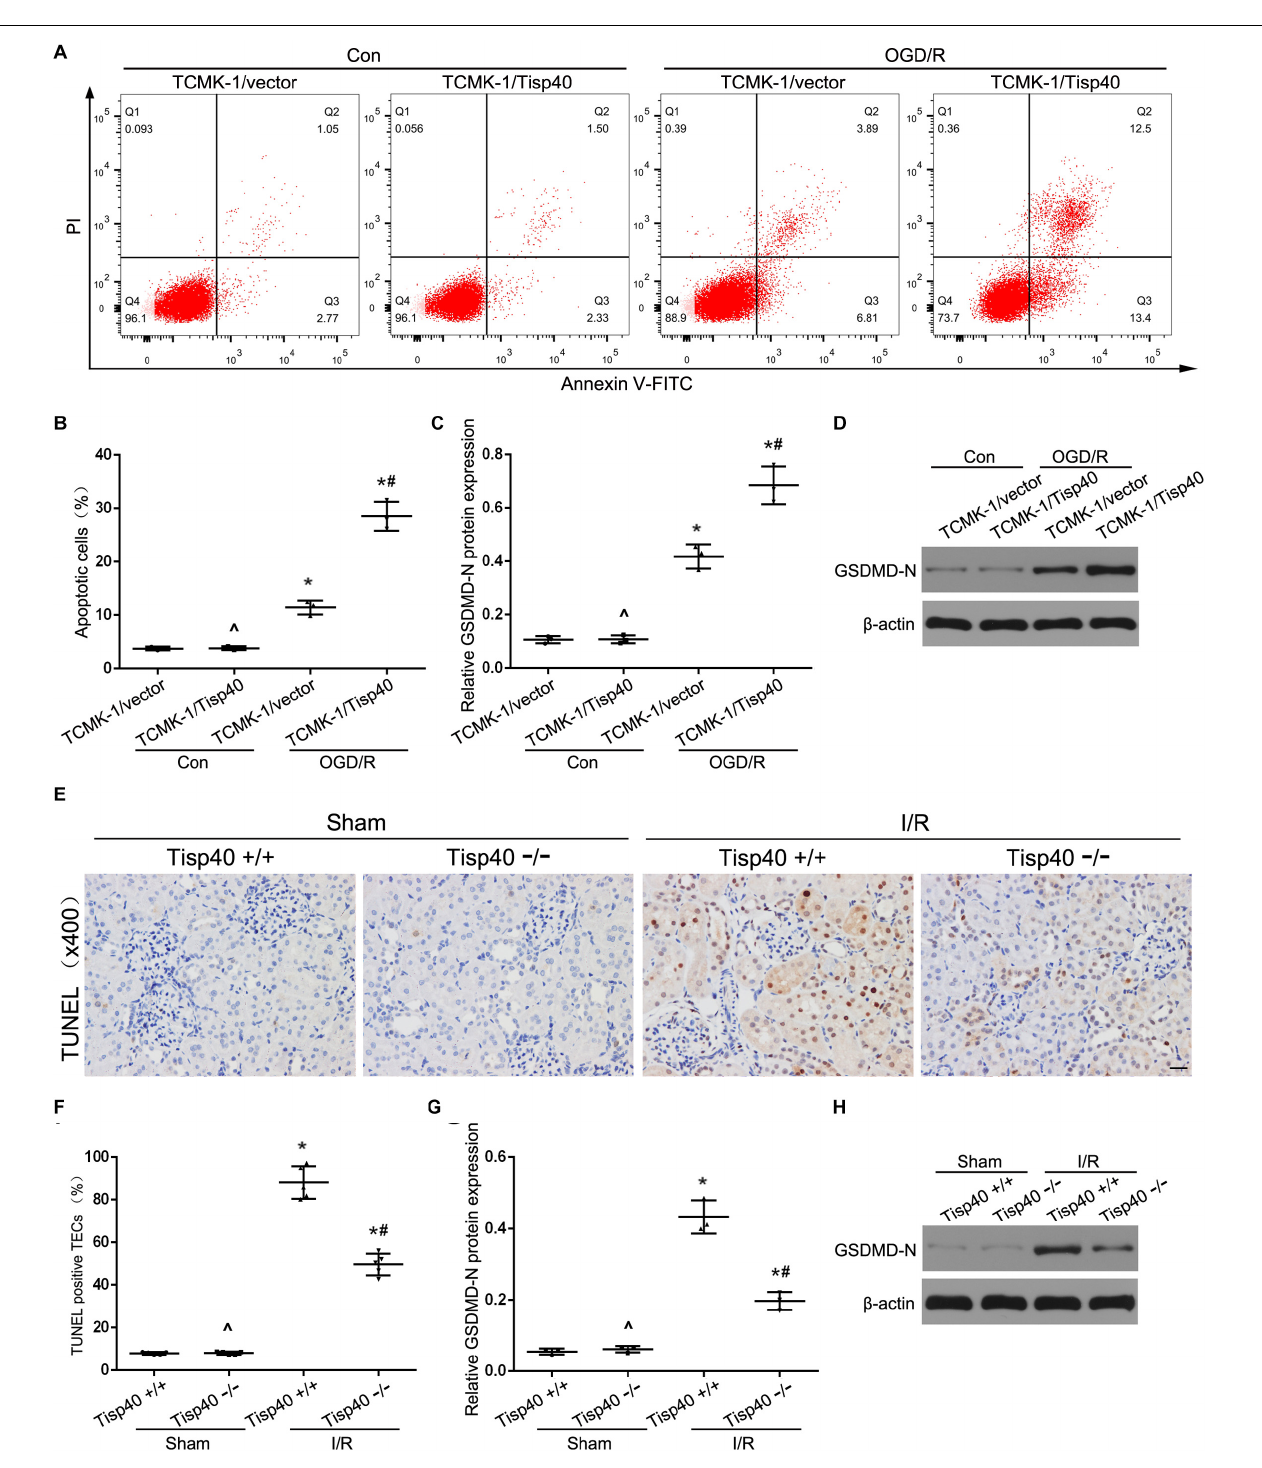
FIGURE 6 | Tisp40 was an essential regulator of GSDMD-mediated TECs pyroptosis. (A) Flow cytometry assays were performed to show the cell pyroptosis. (B) Statistical analysis was used to show pyroptosis cells. (C,D) The expression of GSDMD-N in TCMK-1 cells were analyzed by Western blot. (E) Representative photomicrographs of tubular cell injury in mouse kidney tissue sections with TUNEL staining, 400 × , scale bar = 20 µ m. (F) Statistical analysis showed the percentage of TUNEL positive TECs in the kidney tissues exposed to sham or I/R. (G,H) The expression of GSDMD-N in kidneys were analyzed by Western blot. Data are expressed as the mean ± SD. n = 5 per group in vitro and n = 6 per group in vivo . ˆP > 0.05 vs. TCMK-1/vector cells in con group or. Tisp40 + / + mice in sham group. * P < 0.05 vs. corresponding control groups (Con) or sham-operation groups (Sham). # P < 0.05 vs. TCMK-1/vector cells in OGD/R group or Tisp40 + / + I/R group, one-way